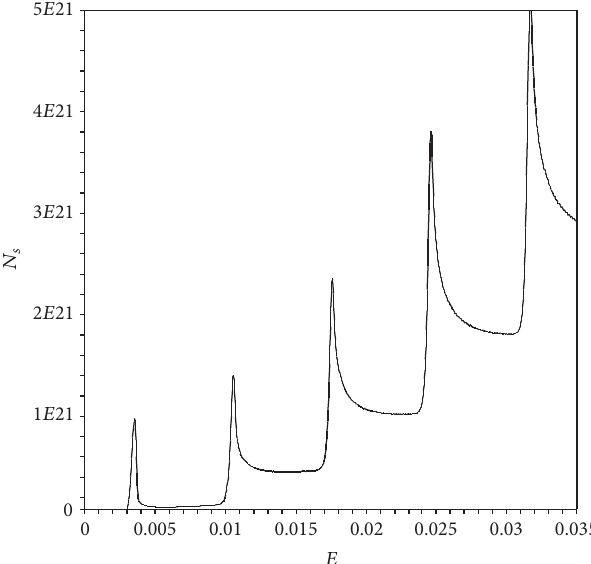
Figure 1: Density of energy states in a high magnetic field 𝐵 = 2 T at a temperature 𝑇 = 1K as calculated using formula (14).